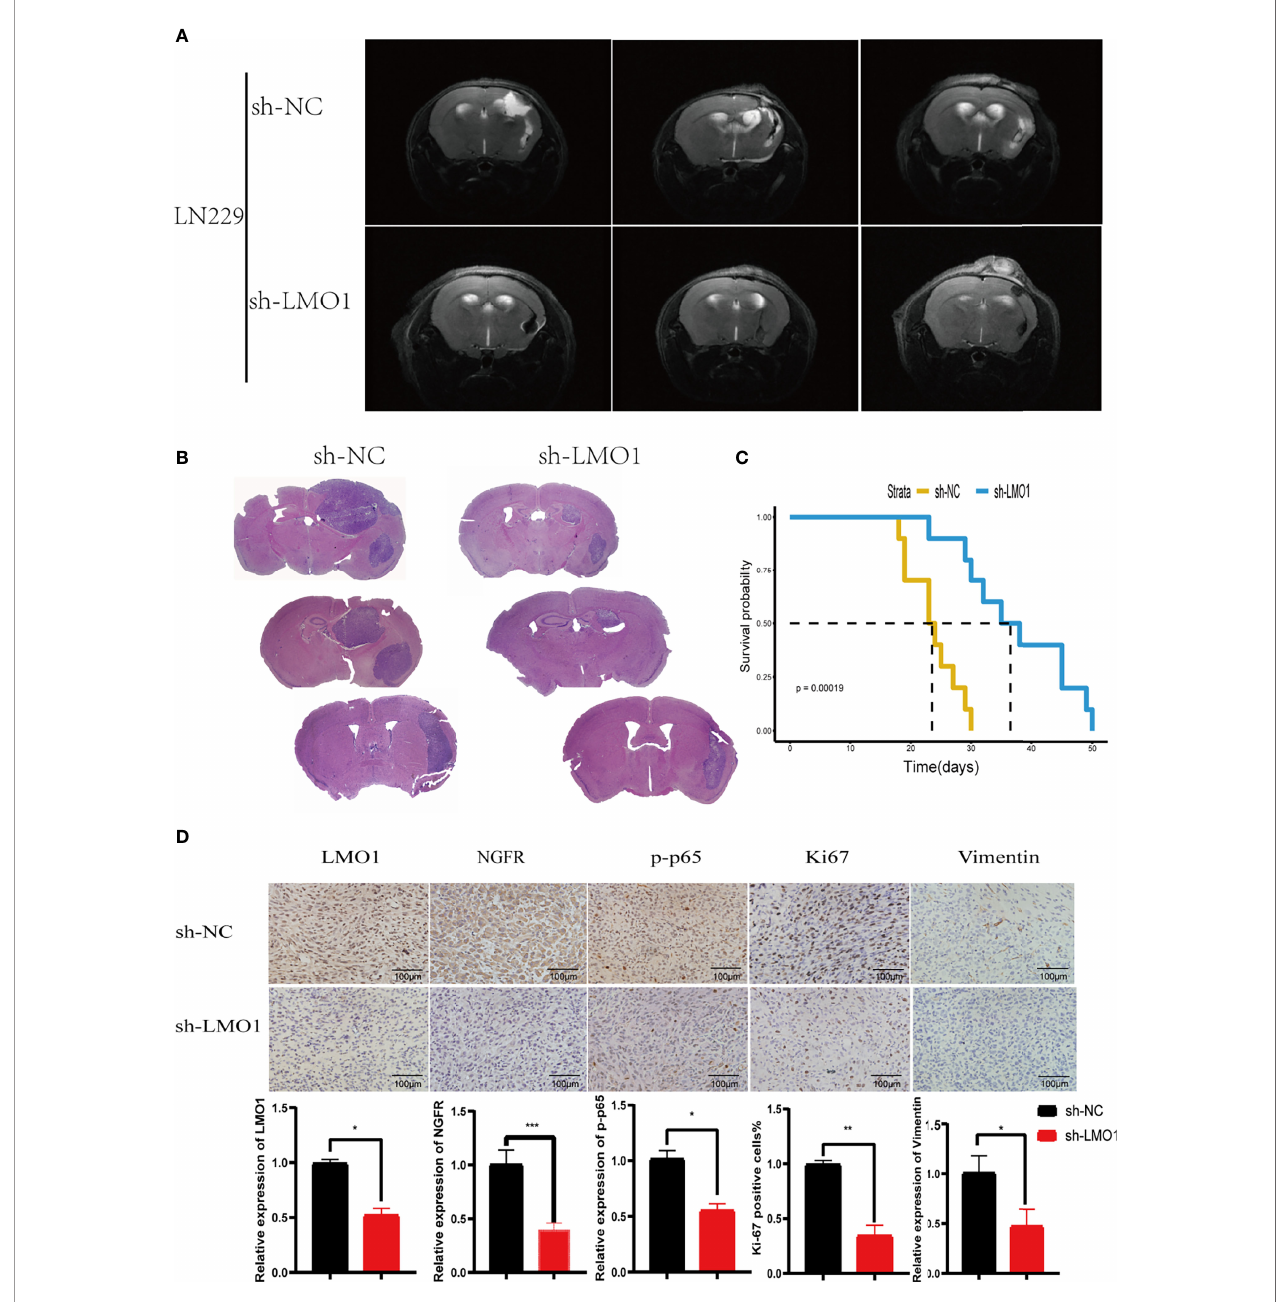
FIGURE 6 | LMO1 silencing inhibits tumorigenesis in vivo . (A) Cranial MRI T2 sequence images of intracranial tumor-bearing mice in LN229 control or sh-LMO1 cells at 3 weeks after transplantation. (B) H&E staining of sections from mouse brains with LN229 control or sh-LMO1 xenografts at 15 days after implantation. (C) Survival analysis for animals implanted with LN229 sh-LMO1 or control cells (n control = 6, n sh-LMO1 = 6).Log-rank tests were used to calculate p-values. (D) IHC for LMO1, p-p65, Ki-67 and Vimentin in sections from indicated xenografts (scale bar=100 m m). the lower panels show histograms of the results. Student ’ s t test was used for statistical analysis. *p < 0.05. **p < 0.01. ***p <